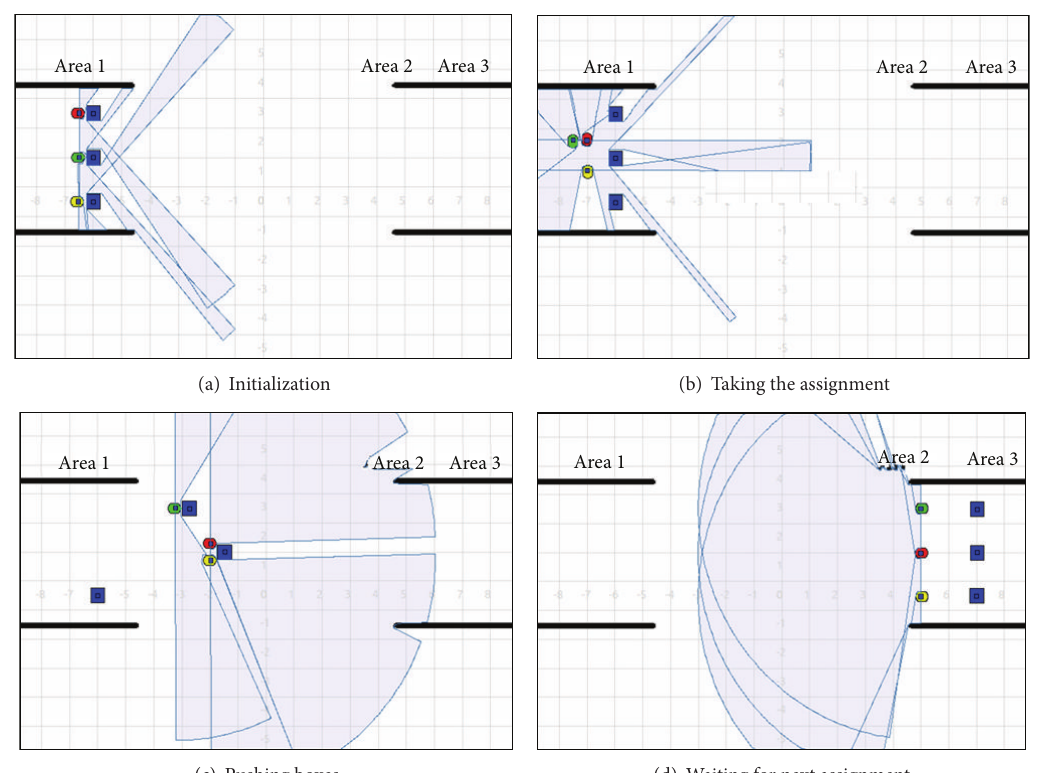
Figure 4: Simulation process of the